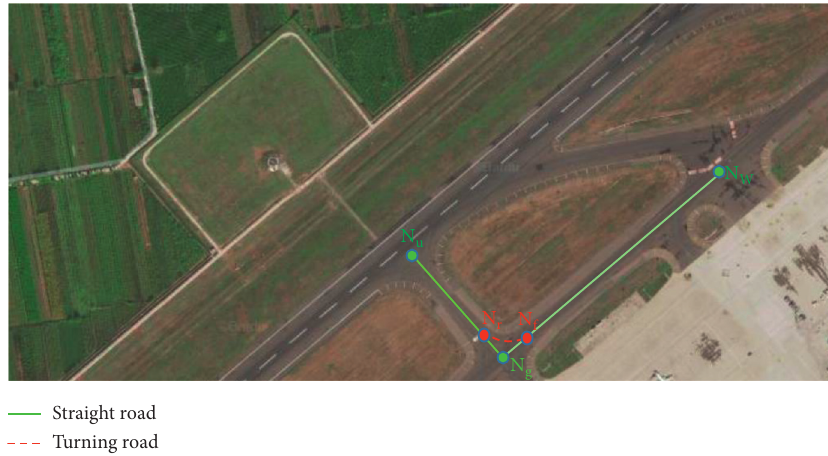
Figure 1: The taxiing process of the aircraft turning